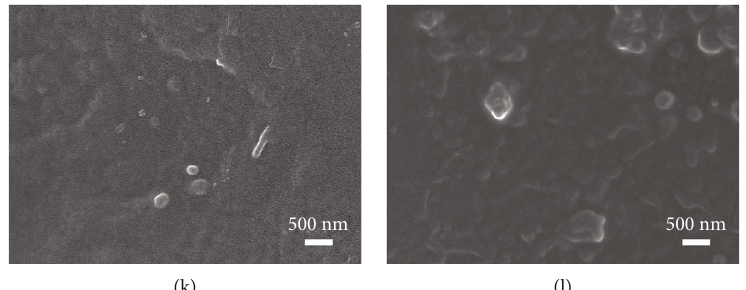
Figure 5: Surface and cross-sectional SEM images of PEG/MYNS MMMs with di ff erent MYNS contents: (a, b) 0, (c, d) 1, (e, f) 2, (g, h) 3, (i, j) 4, and (k, l) 5wt.